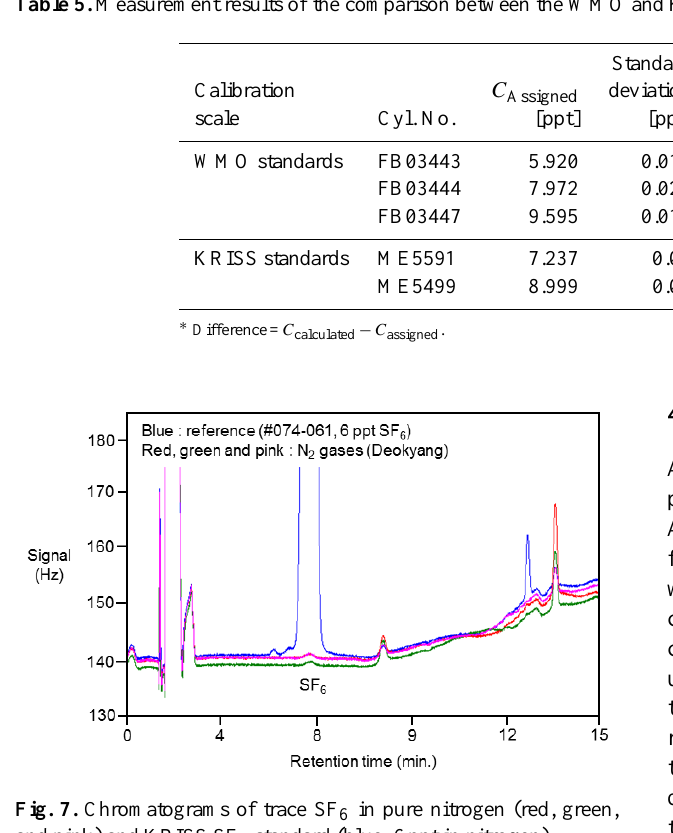
Table 5. Measurement results of the comparison between the WMO and KRISS standards.